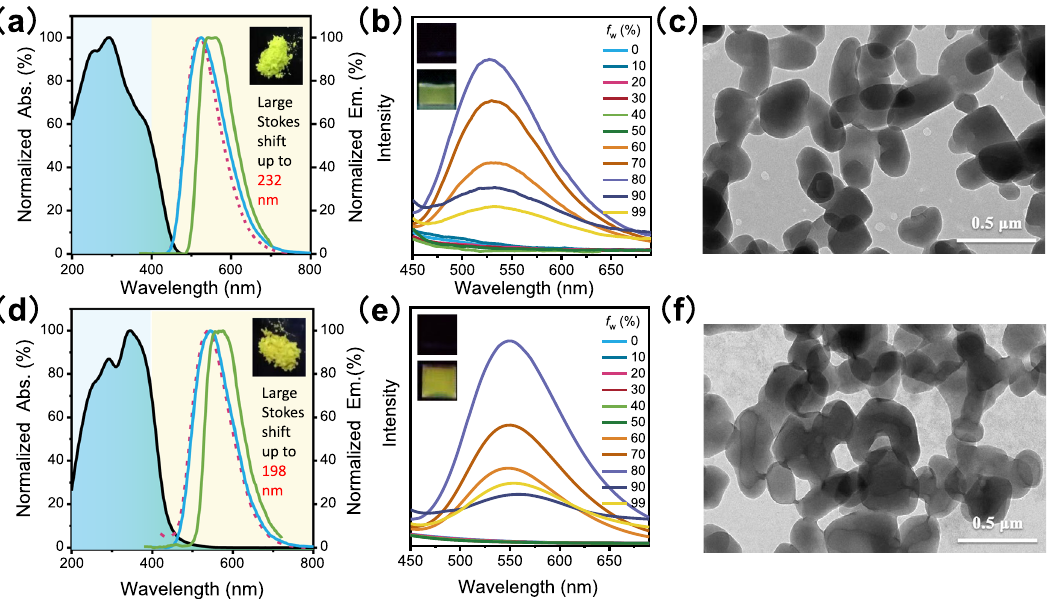
Fig. 2 Photophysical properties and nanoparticle morphology. UV absorption spectra in the solid-state (black line), steady-state emission spectra in the solid-state (red line) and phosphorescence spectra (50 μ s delayed) in the solid-state (blue line) and THF at 77 K (10 μ M, green line) of a TPM and d TPM- Cl. Abs.: absorption, Em.: emission. Inset: photographs of TPM/TPM-Cl as crystalline powders under 365 nm light irradiation. Emission spectra of b TPM and e TPM-Cl nanoparticles with different water fractions in H 2 O/THF mixtures. f w : water volume fraction. Inset: photographs of nanoparticles with 0% (up) and 80% (down) water fractions under 365 nm light irradiation. TEM images of the c TPM and f TPM-Cl nanoparticles. Each experiment was repeated three times